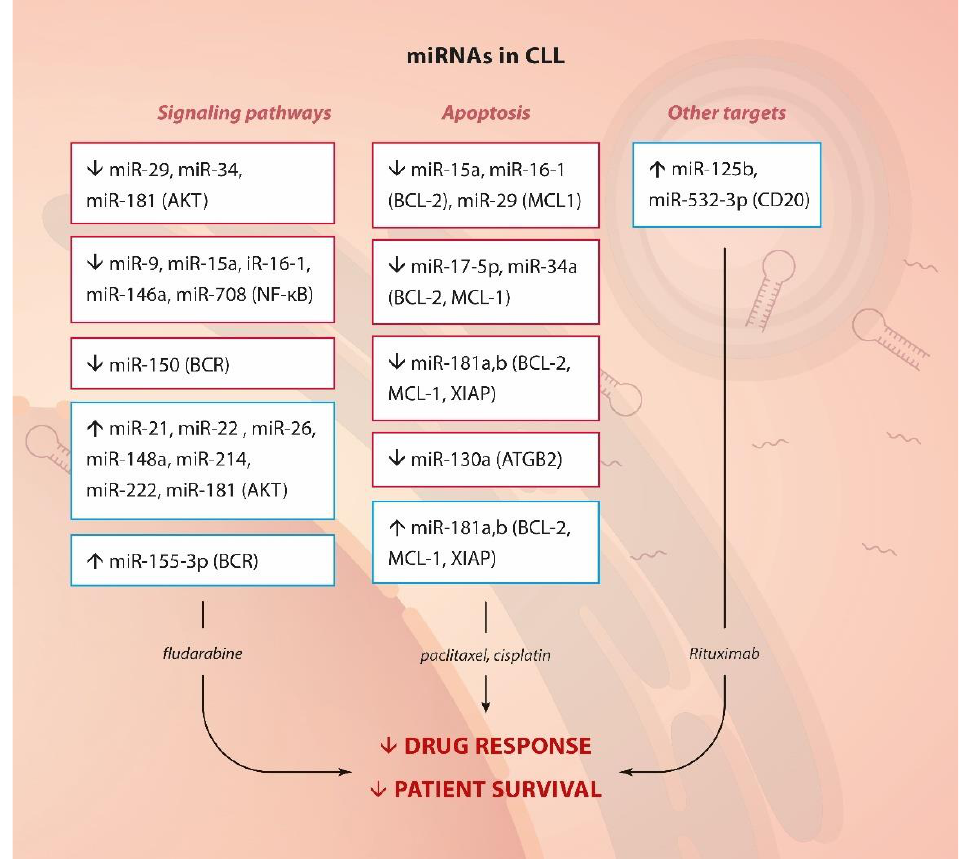
Figure 3. miRNA and drug resistance in CLL. Summary of up- or down-regulated miRNAs, their targets or pathways they affect (in brackets) and their involvement in drug resistance.